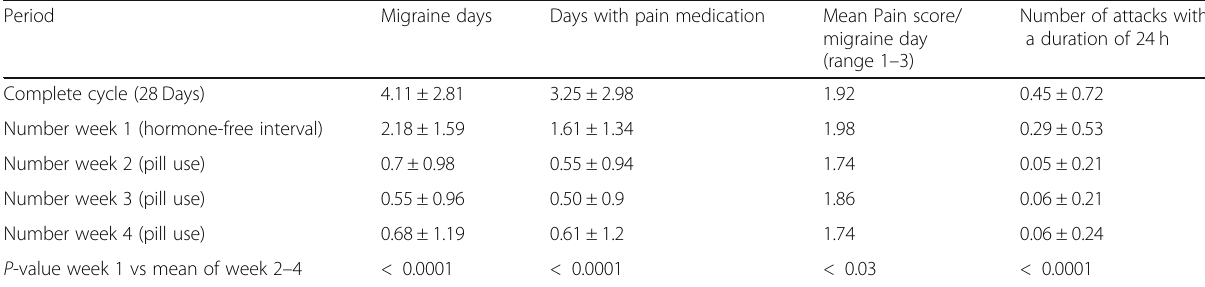
Table 1 Migraine characteristics during the whole cycle and for each week of the cycle Period